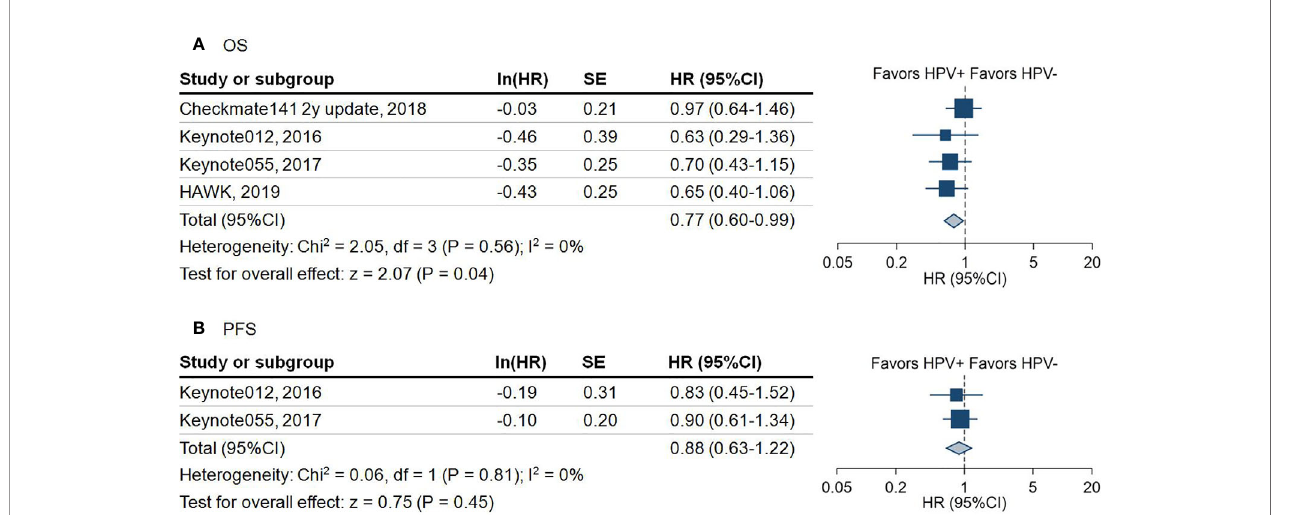
FIGURE 3 | Forest plot for the survival outcome of anti-programmed death-1/programmed death-ligand 1 agents in patients with different human papillomavirus status. (A) Overall survival (OS) of included studies. Squares indicate adjusted effect size (hazard ratio [HR]). Horizontal lines represent 95% con fi dence interval (95% CI). Diamonds represent the pooled HRs. (B) Progression-free survival (PFS) of included studies. Squares indicate adjusted effect size (hazard ratio [HR]). Horizontal lines represent 95%CI. Diamonds represent the pooled HRs. Pooled HRs were calculated using the fi xed-effect model. PD-1, Programmed death 1; PD-L1, Programmed death-ligand 1; HPV, human papillomavirus; +, positive; -, negative; SE, standard